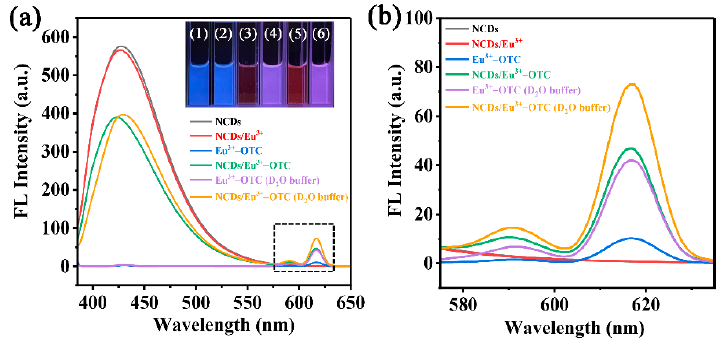
Figure 4. ( a ) Fluorescence spectra of different systems. Inset: 1–6 successively represent fluorescence images of different systems excited by 365 nm UV light. ( b ) Enlarged area in ( a ). HEPES buffer: 20 mM, pH = 7.0; NCDs: 20 mg·L − 1 ; Eu 3+ : 60 µM; OTC: 10 µM; λ ex = 375 nm.